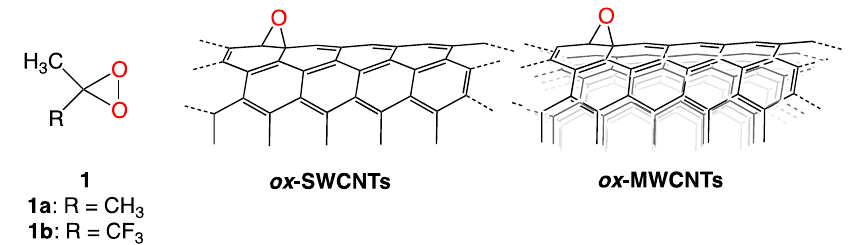
Figure 1. Chemical structure of 1 , ox -SWCNTs and ox -MWCNTs.